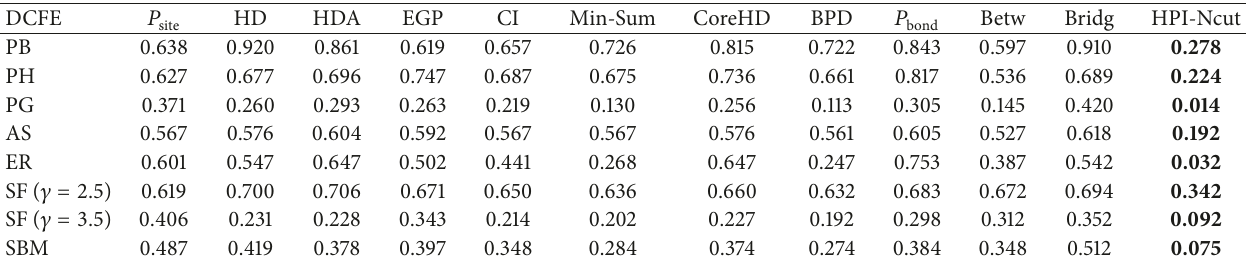
is short for site percolation, site